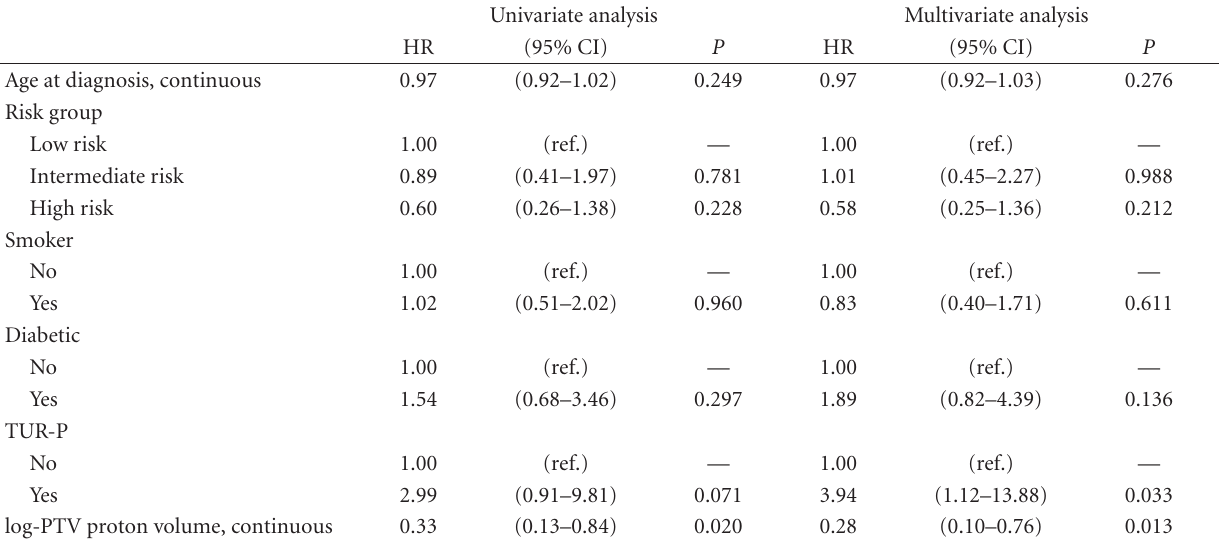
Table 5: Cox regression model—GU grade 2 or higher ∗ . Univariate